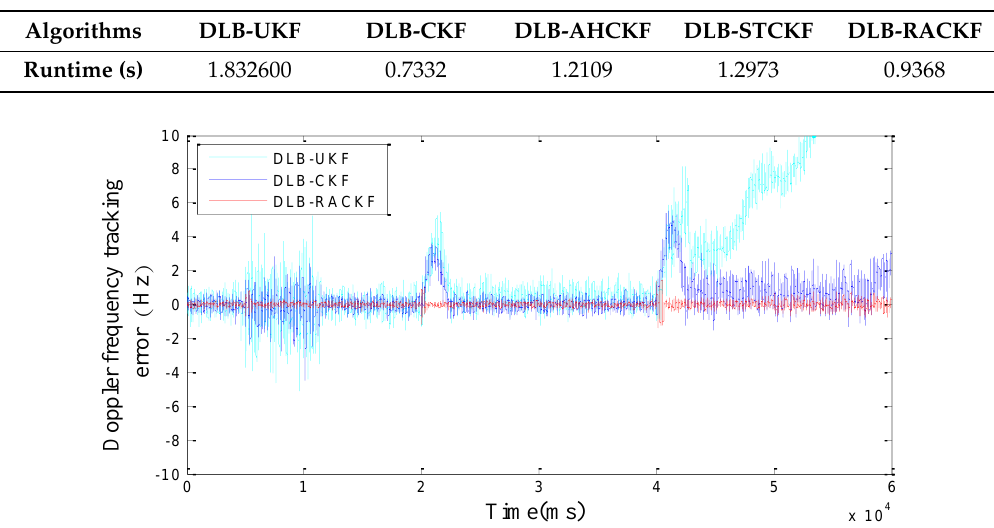
Table 2. Runtime of five tracking algorithms.